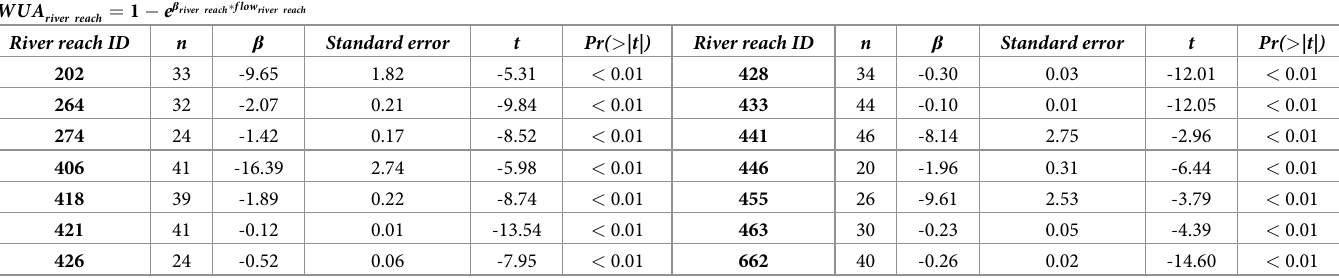
reach. tat size and the ecosystem potential to contain species given a specific flow. The benefit B eco of s ecosystems in reach s depends on the ecosystem health status EW eco (from zero to one), the s length l of the reach (km), and the economic value VE of ecosystem services ( € /km) (Eq 15). s s The economic value of ecosystem services VE is derived from published studies in the liter- s ature. Values are usually given in euros per hectare of riverbed, which can be converted to euros per kilometer by knowing the surface area of the river reach covered by water and the length of the river reach. Valuation in the literature ranges from 2,000 to 40,000 € /ha of river- bed covered by water [65,76,77], and from this range we select an average value of 24,000 € /ha for ecosystems’ services in the Ebro. The area covered by water in the rivers of the Ebro basin is 68,000 ha with a total length of 8,900 km [81], therefore the average value in euros per kilo- spatially heterogeneous in the basin, with values higher for mountain rivers than for streams in Table 1. Results of the WUA regression for 14 river reaches in the